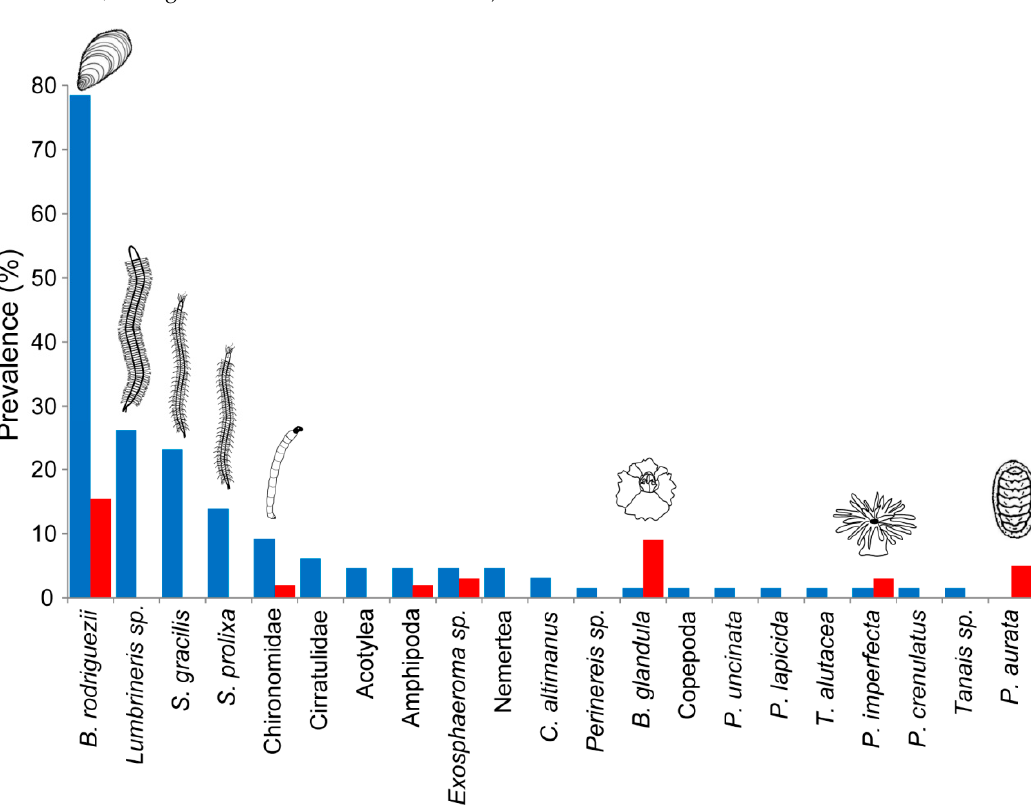
Figure 3. Prevalence (% of samples with species present) of invertebrate species in Petricola -engineered (blue bars) and unengineered (red bars) patches. The most frequent species in the two different habitats are represented by an icon (see text in Results).